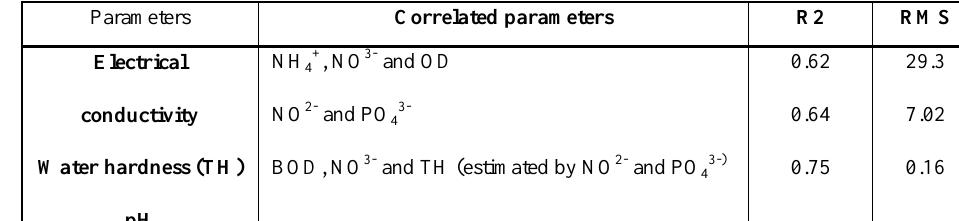
Table 1: Correlation between simulated parameters